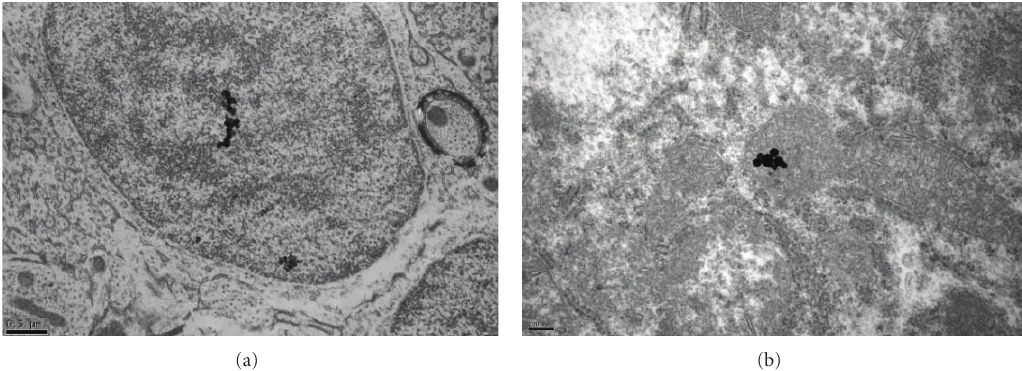
Figure 10: TEM image of the brain (a) and liver (b) of the common carp ( Cyprinus carpio ) exposed to 200 µ g/L of Ag-NPs for 96 h.